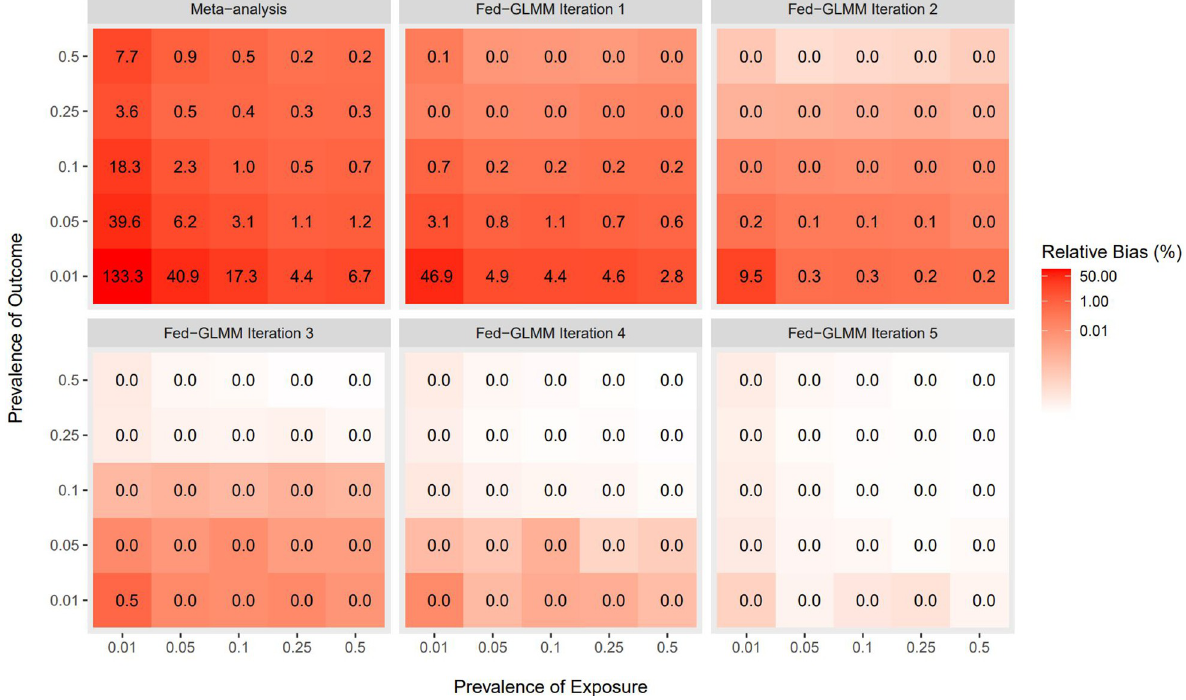
Fig 2. Accuracy of Fed-GLMM and meta-analysis estimates relative to the gold-standard pooled analysis. We compared the accuracy of Fed- GLMM with the standard meta-analysis by calculating the median absolute relative difference compared to the gold-standard pooled estimate of the coefficient of a binary exposure variable. The underlying model has a binary outcome, a binary exposure, three more covariates with 8 site-specific fixed effect coefficients for the normally distributed covariate and a patient-level random intercept. The model also includes 8 site-specific parameters for variance components. We considered 25 combinations of outcome and exposure prevalence to assess the model accuracy with 100 simulation replicates per combination. Fed-GLMM demonstrated reduced relative bias after 1–2 iterations compared with the meta-analysis, which was highly biased in the presence of rare